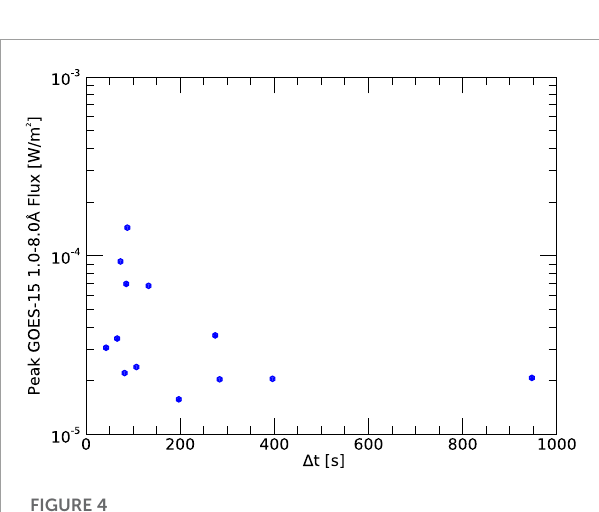
FIGURE 4 Time delays between the start of the GOES SXR flare and the EIS triggered response plotted as a function of the peak SXR